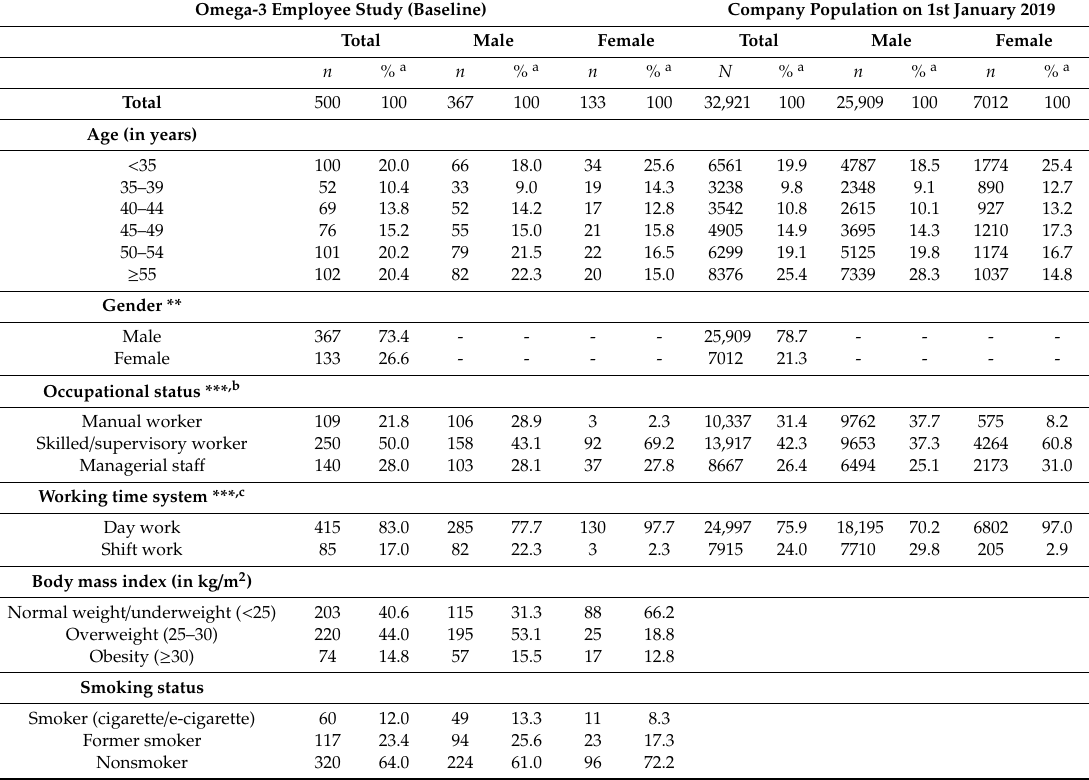
Table 1. Sociodemographic, occupational and lifestyle-related factors of participants in the Omega-3 Employee Study at baseline compared to the overall company sta ff at the BASF Ludwigshafen site